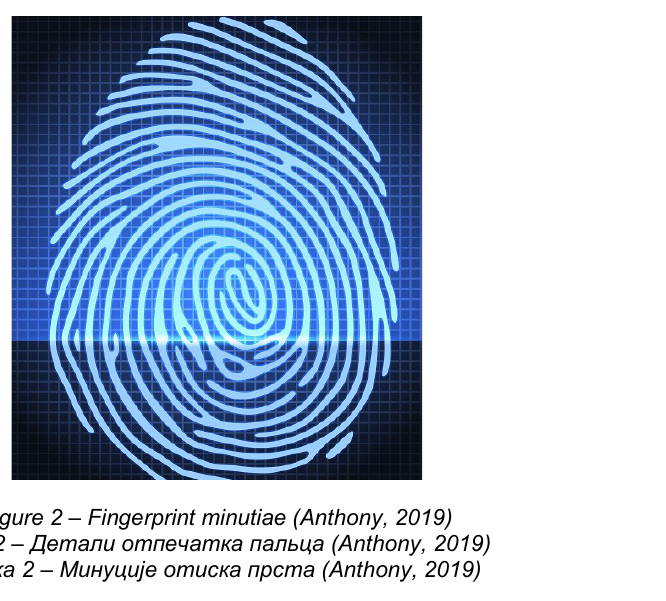
Figure 2 – Fingerprint minutiae (Anthony, 2019) Рис. 2 – Детали отпечатка пальца (Anthony, 2019) Слика 2 – Минуције отиска прста (Anthony,